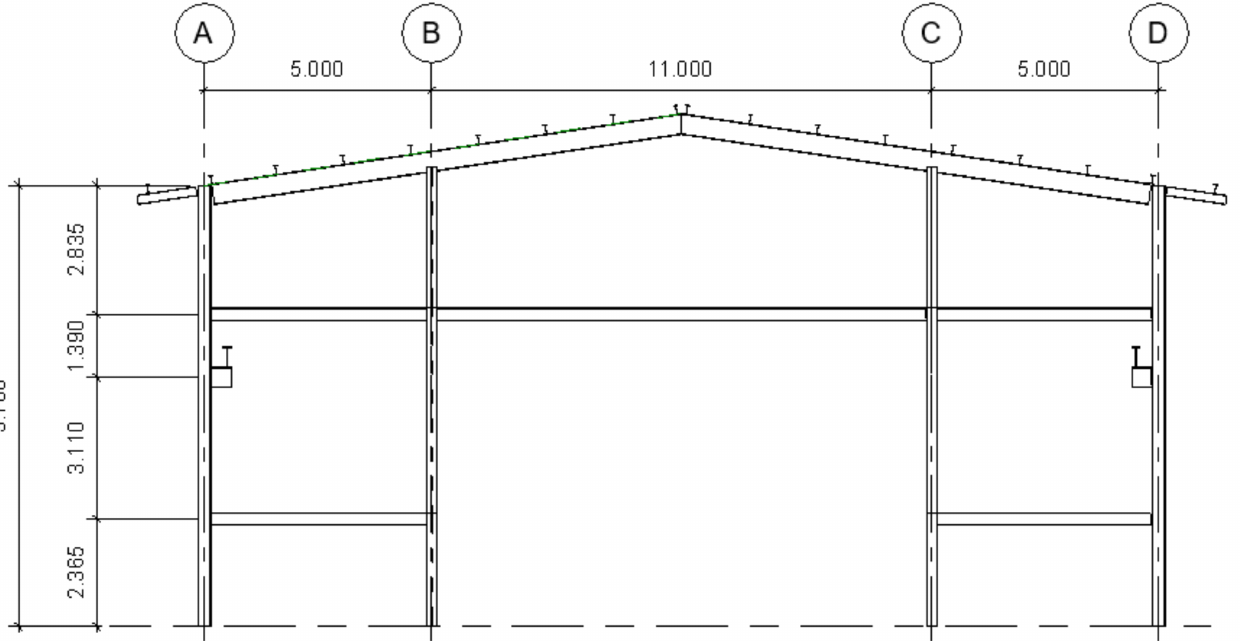
Figure 1. Elevation view of the outer frames (dimensions in m). A, B, C and D are the structural axis. The columns of the entire structure are embedded in one of its ends (base–base). The columns on the sides of all the frames are 9.7 m high from the base, whereas the central columns of frames 1 and 7 are 10.45 m high. In addition, each frame has a pair of corbels on its external columns to support the loads the overhead crane exerts. These corbels are located 5.7 m from the base of the column (as well as the side beams) and have a width of 0.5 m from the junction with the column. Side bracing is also used between the 1–2, 3–4, 4–5, and 6–7 frames, and top bracing between